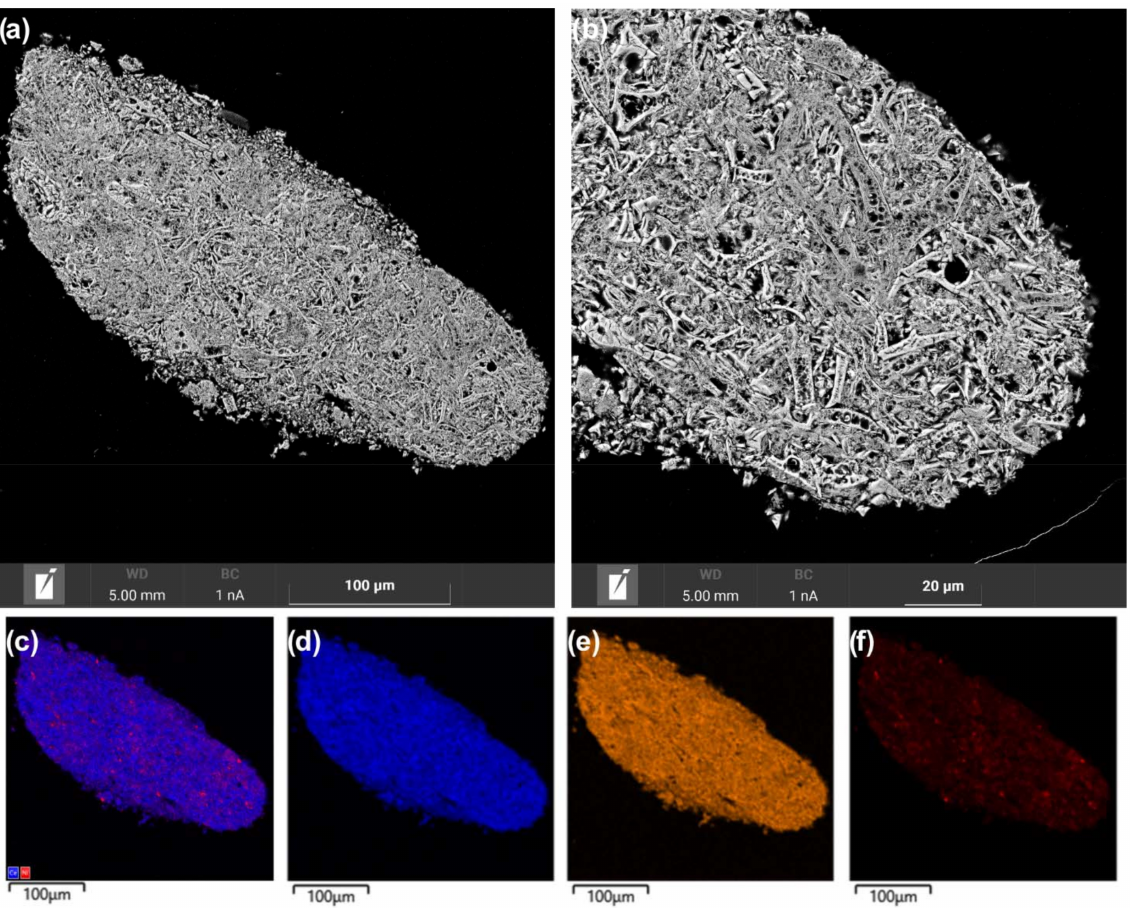
Figure 6. SEM images ( a , b ) and EDX mapping patterns ( c – f ) for nickel (red), zirconium (orange), and cerium (blue) of cross-section area of the Ni/Ce 0.5 Zr 0.5 O 2